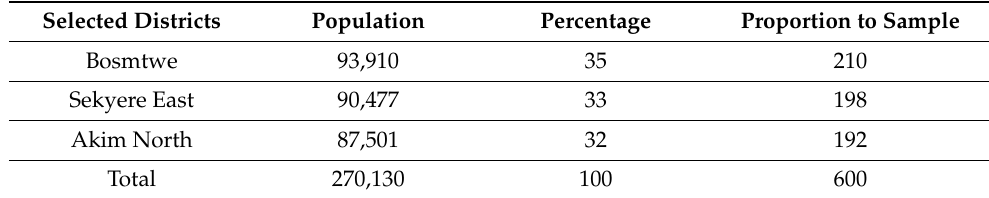
Table 1. Sample Distribution.